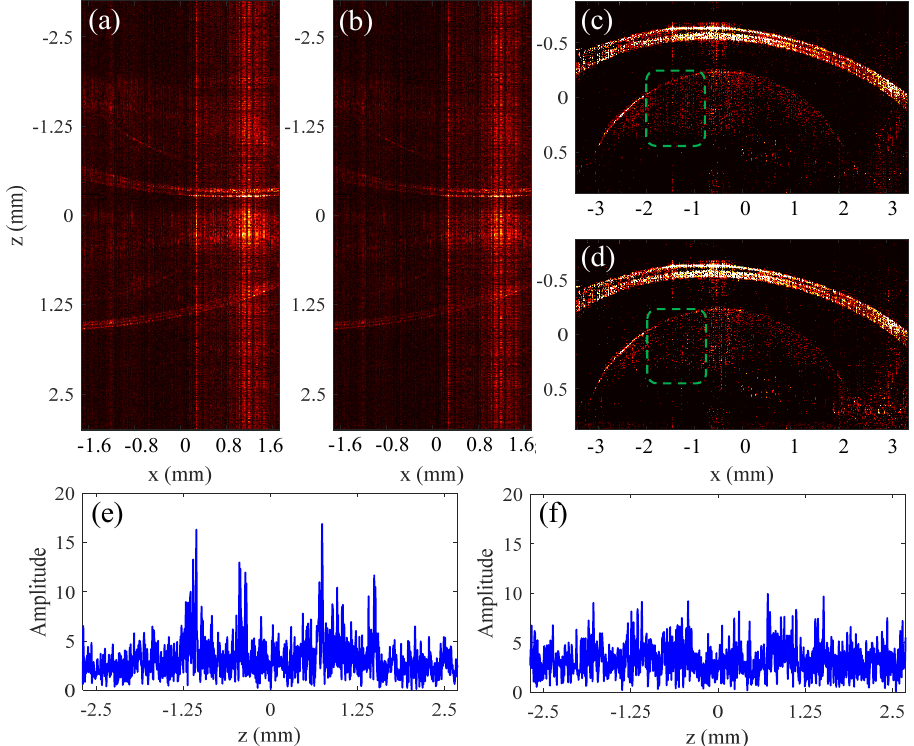
Figure 7. Experiment results of a fish eye. The results in ( a , c , e ) are obtained using 35% spectral data, and the results in ( b , d , f ) are obtained using 25% spectral data.